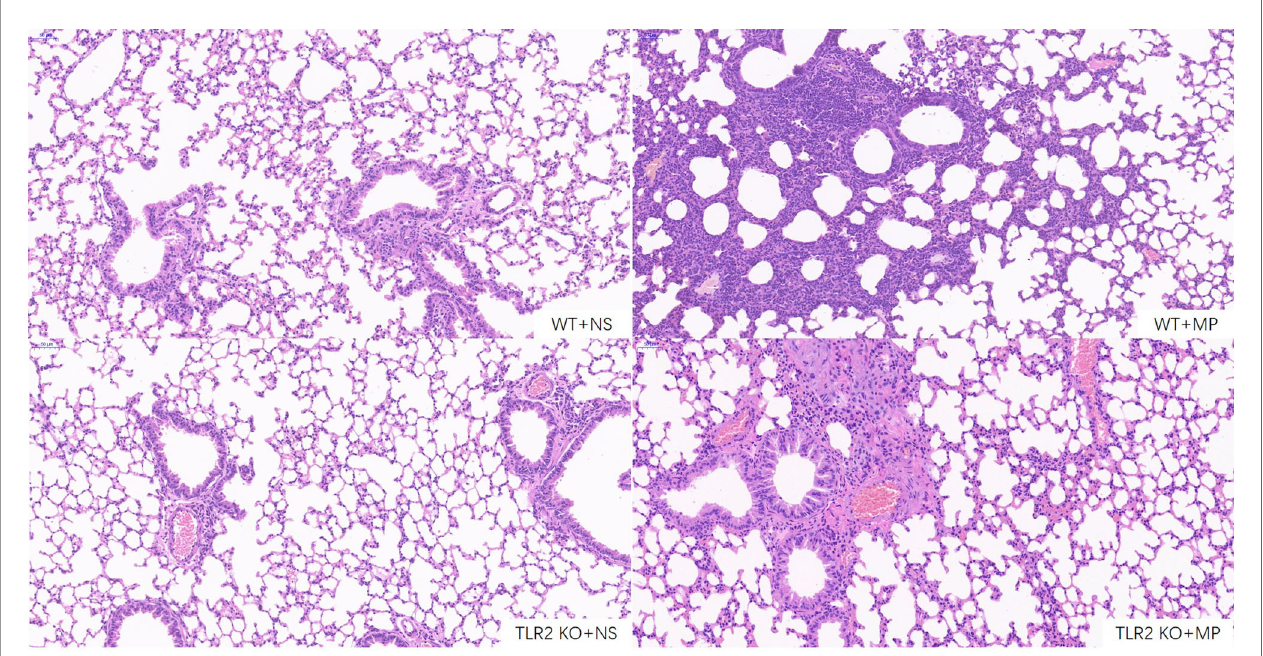
FIGURE 7 | Hematoxylin and eosin staining of lung sections of wild-type and TLR2 knockout mice. Scale bar, 50 m m. WT, wild-type mice; TLR2 KO, TLR2 knockout mice; NS, normal saline; MP, Mycoplasma pneumoniae